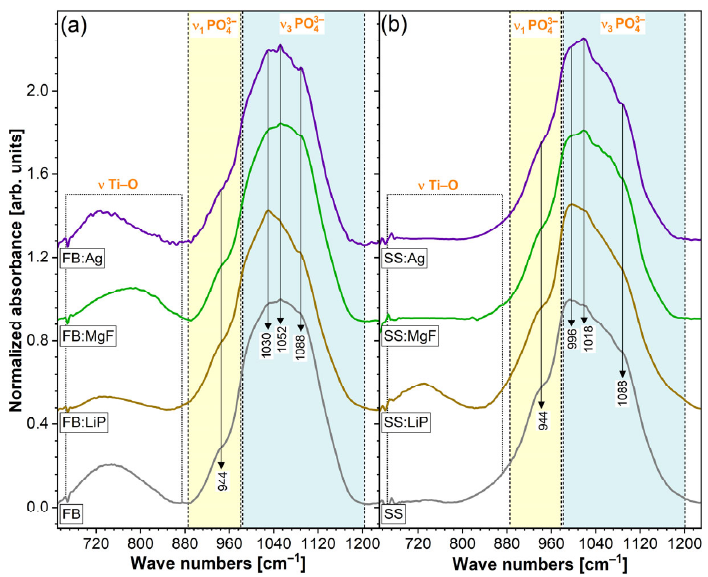
Figure 4. FTIR-ATR spectra of simple and doped FB ( a ) and SS ( b ) thin films.